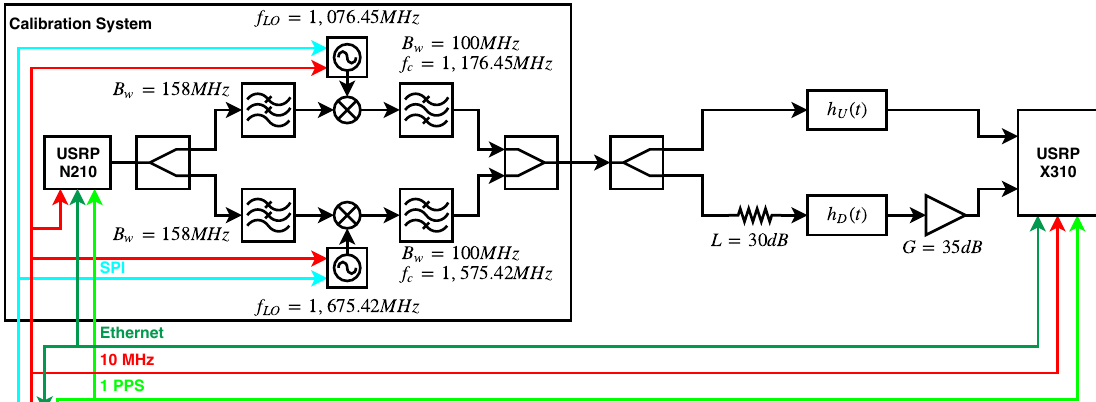
Figure 10. Block diagram of the calibration system. f LO is the frequency of the local oscillator (LO), B w is the − 3 dB bandwidth, f c is the − 3 dB cut-off frequency, L stands for attenuation, and G stands for gain.